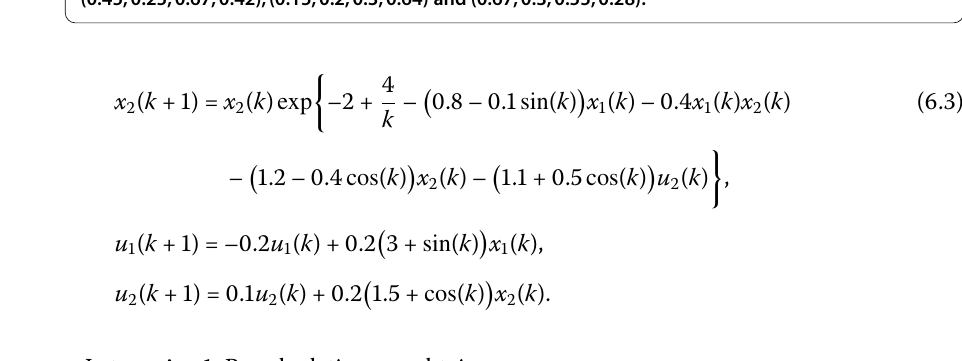
Figure 3 Dynamic behaviors of system (1.3) with initial condition ( x 1 (0), x 2 (0), u 1 (0), u 2 (0)) = (0.45,0.25,0.67,0.42),(0.15,0.2,0.3,0.64) and